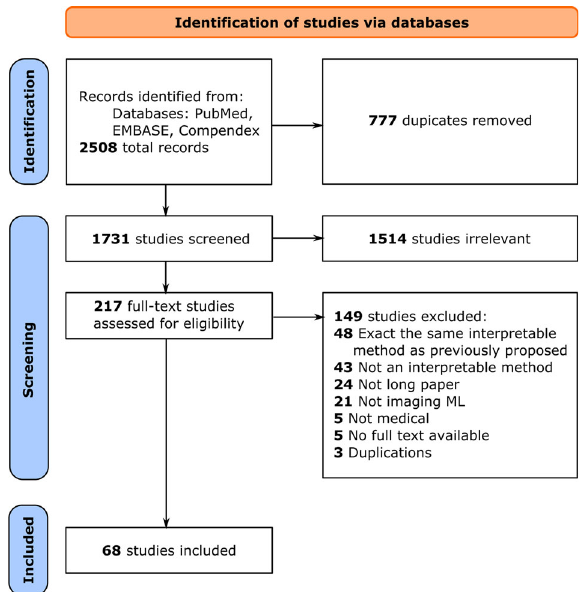
Fig. 4 PRISMA diagram for transparent ML in medical imaging. The fl ow diagram shows the number of records identi fi ed, of studies excluded and the reasons for exclusion, and of studies included in our systematic